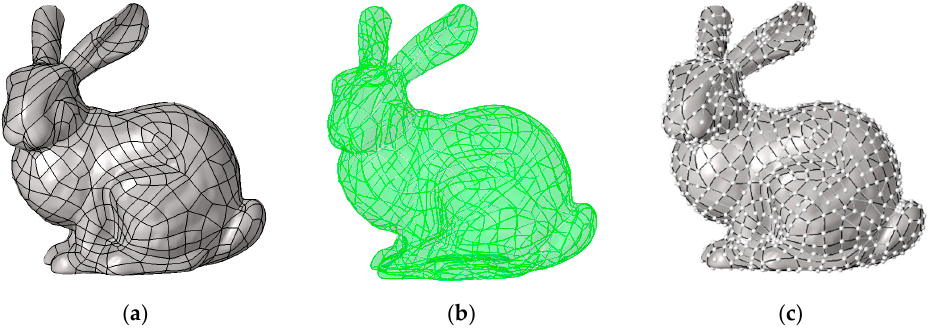
Figure 12. Sampling point acquisition for rabbit model: ( a ) solid model; ( b ) grid division; ( c ) sampling data points.